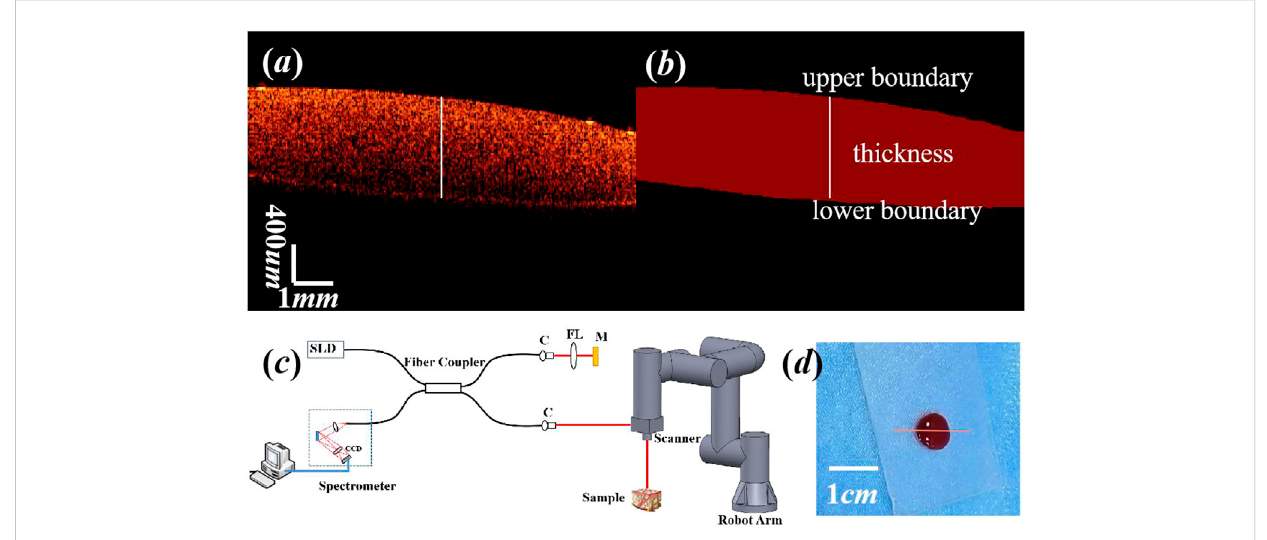
FIGURE 1 (A) Cross-sectionalOCTimageofwholebloodand (B) manuallabelofthewholebloodarea.Imageareawas3 mm(z)×10 mm( x ).Whitelineshows the thickness of whole blood at the local position. (C) Schematic of the experimental setup. SLD, superluminescent diode; C, collimator; M, mirror; FL, focusing lens. (D) Scanning area along the line on whole blood. The thickness of the blood drop is thinner at the right than at the